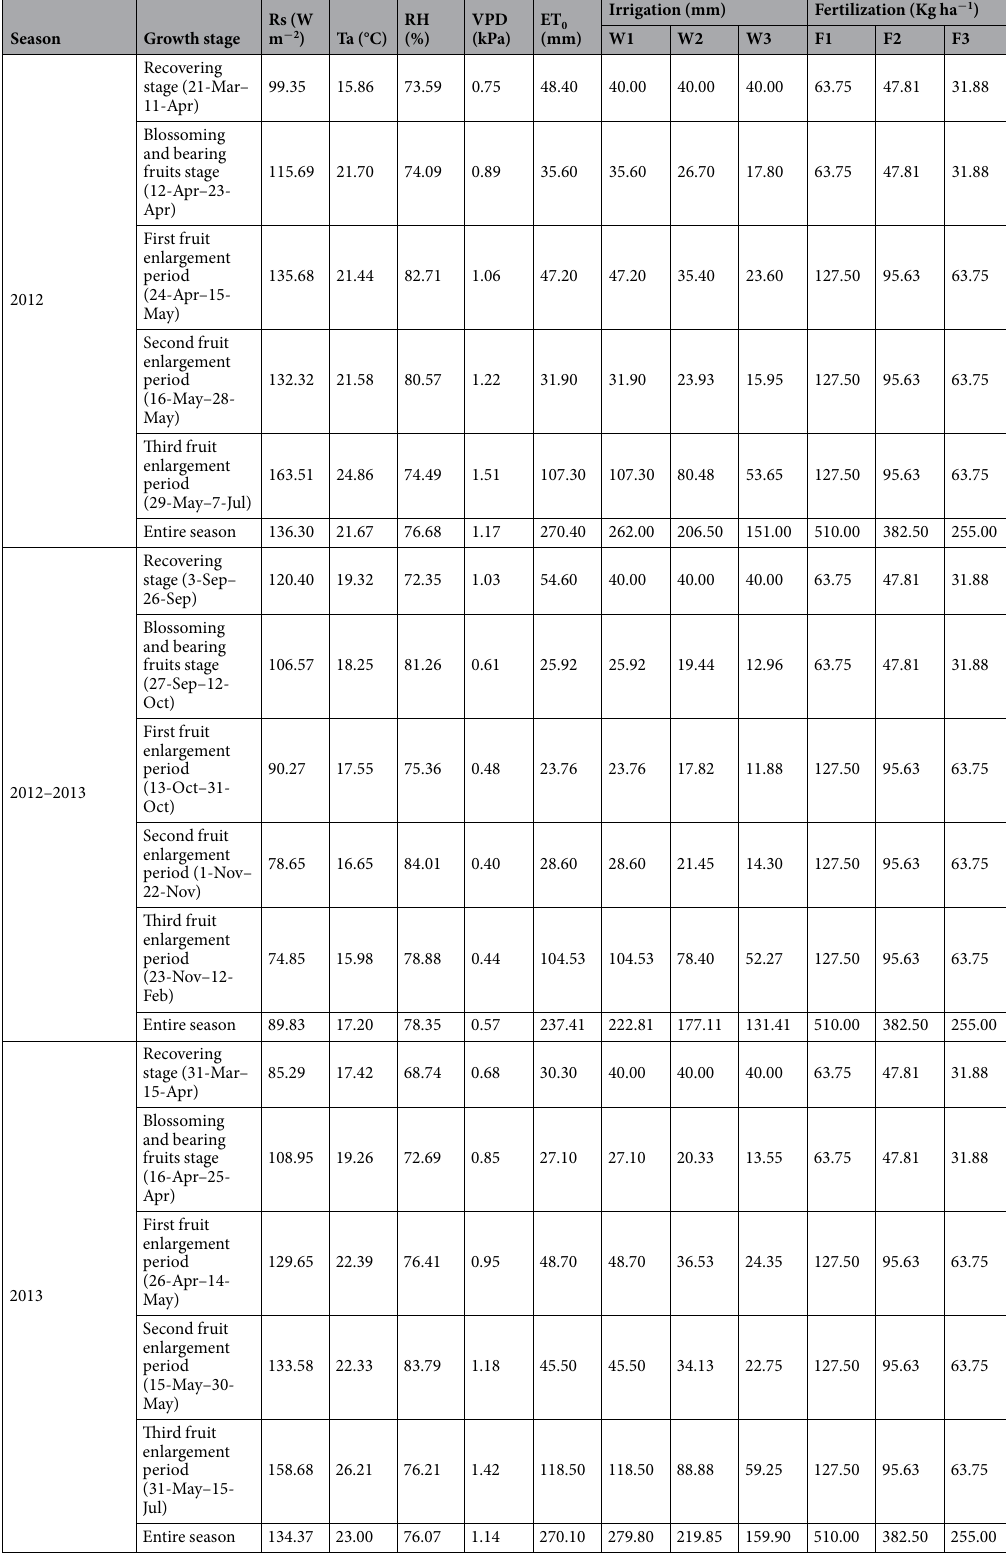
Table 3. Average daily environmental parameters recorded at different growth stages of tomatoes inside the greenhouse. R s is the solar radiation, T a is the air temperature, RH is the relative humidity, VPD is the vapour pressure deficit, ET 0 is the reference evapotranspiration; irrigation treatments (W1, W2 and W3); fertilizer treatments (F1, F2 and